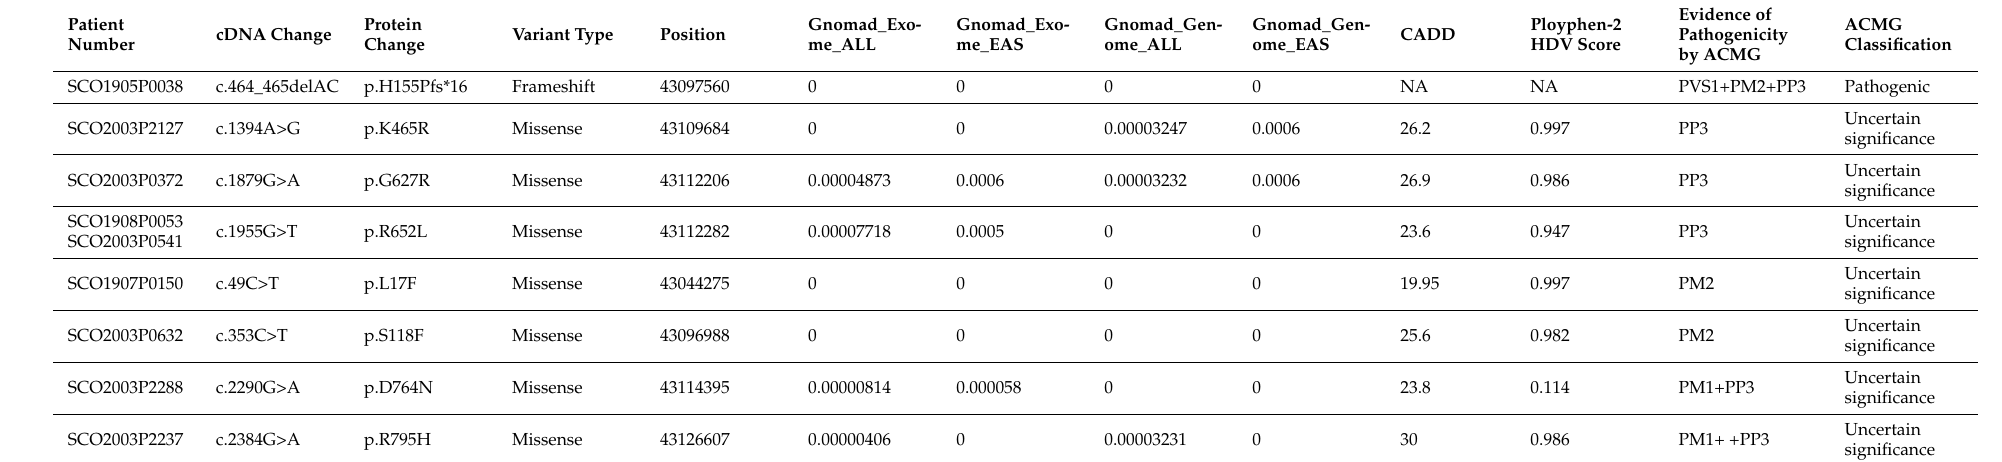
Table 2. Sequence variants identified in PTK7